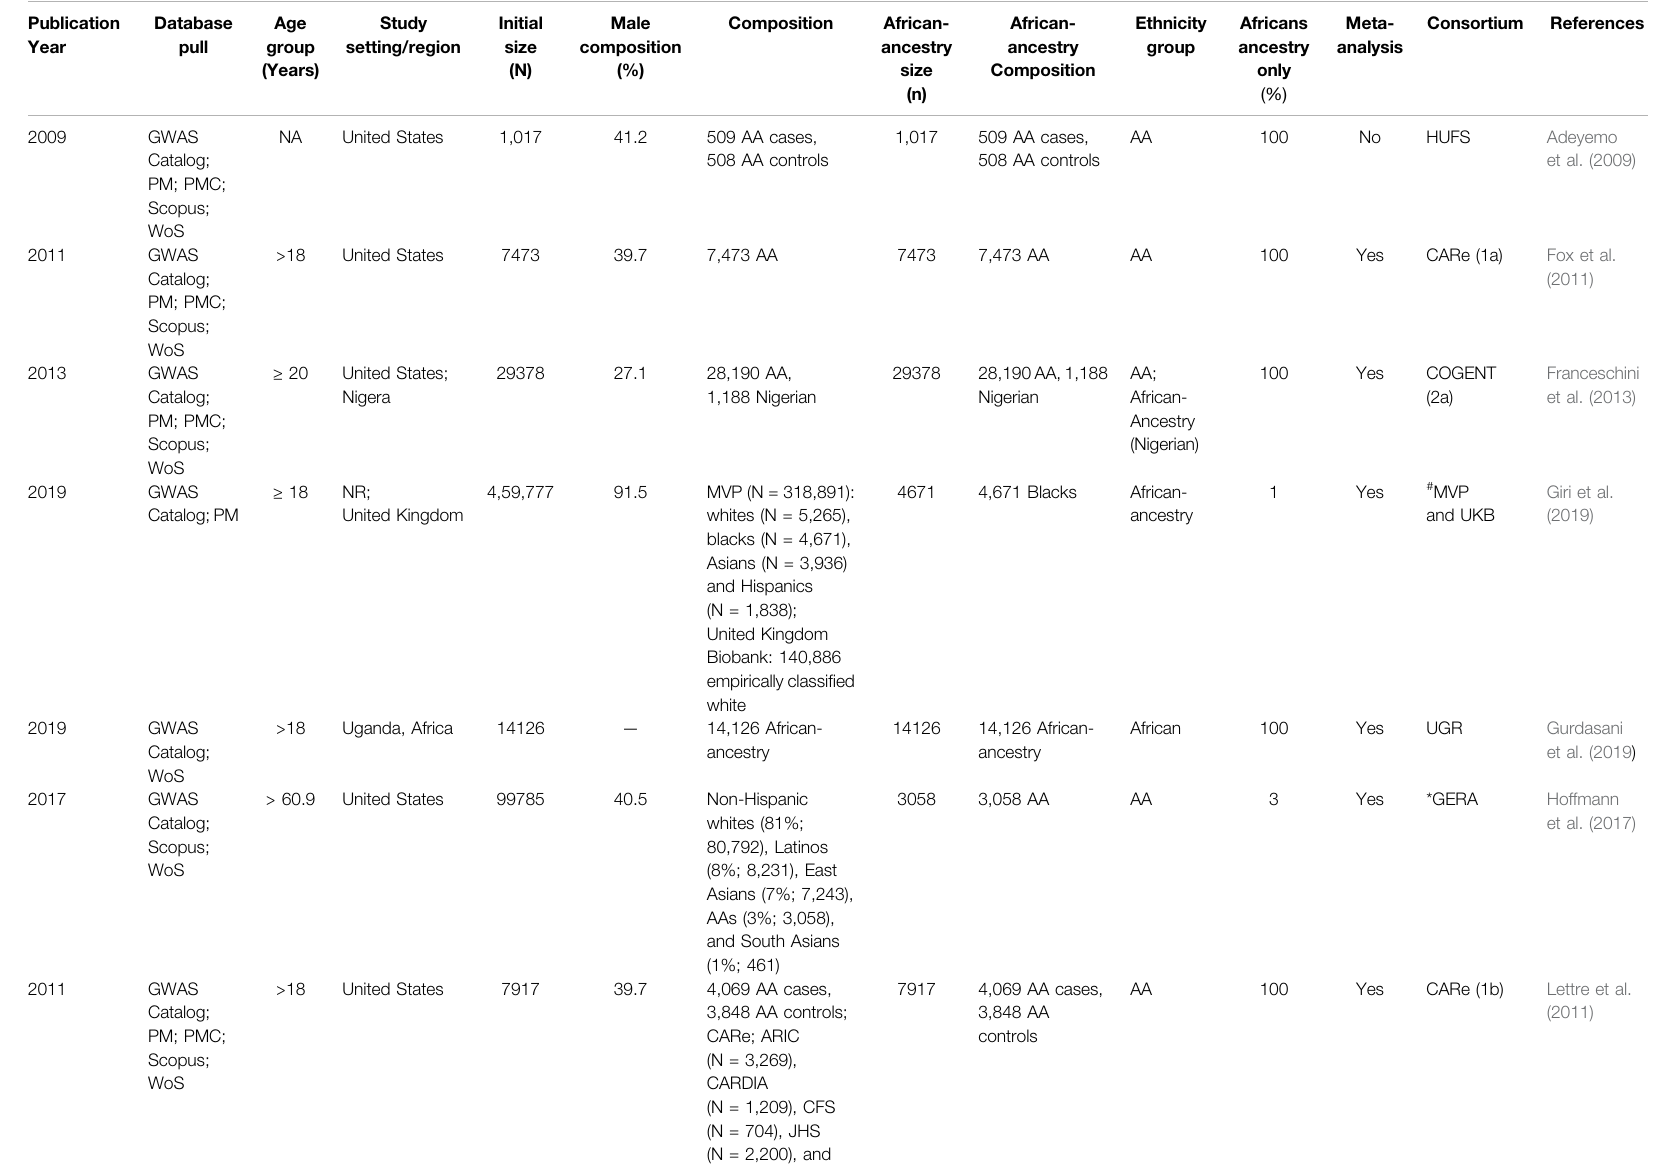
TABLE 1 | Study characteristics of the 12 eligible